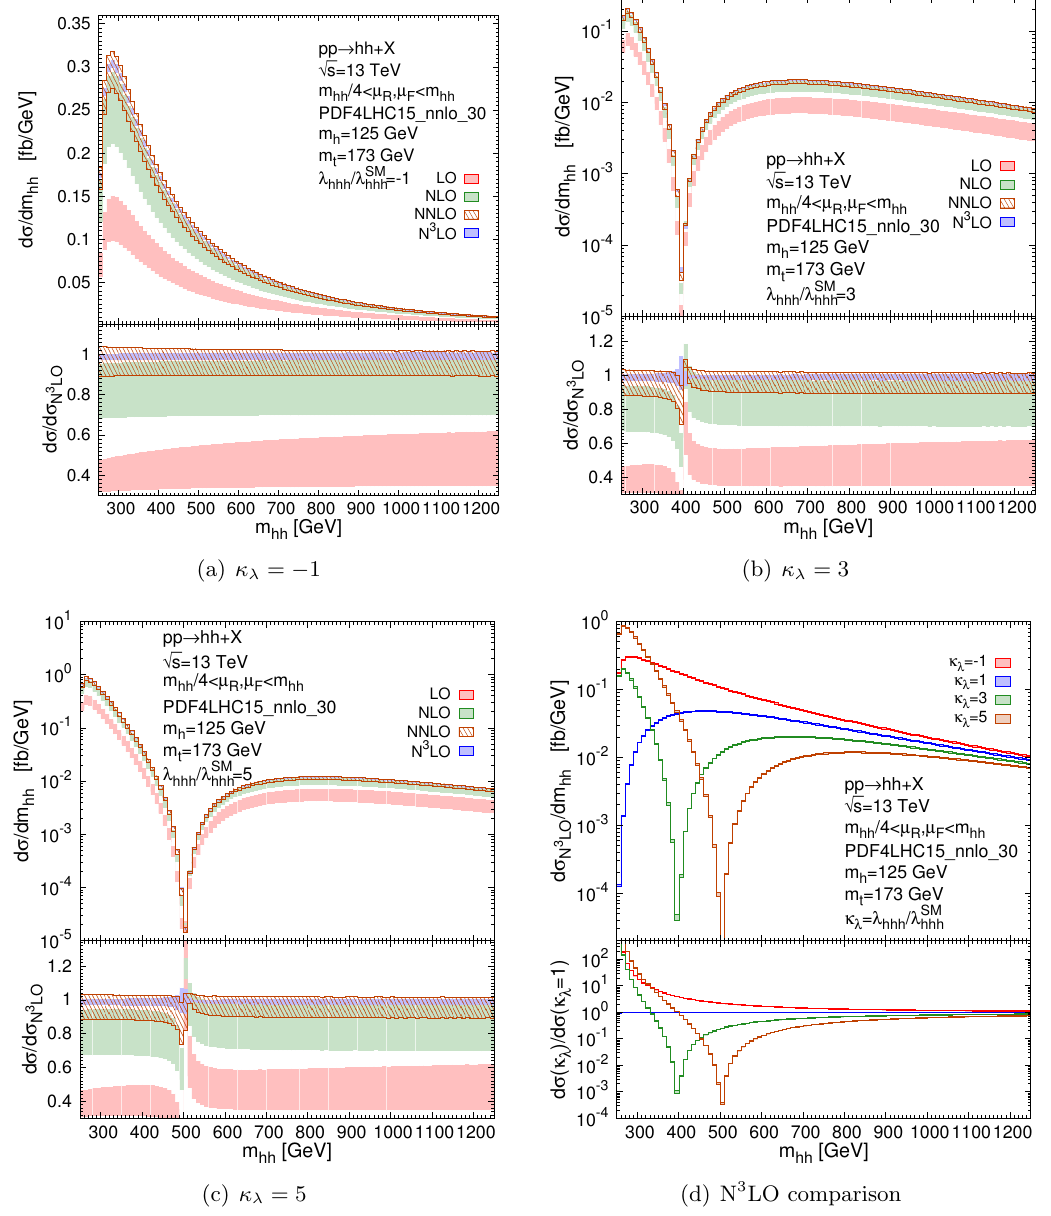
Figure 13 . Invariant mass distributions for the Higgs boson pair production in proton-proton p collisions at s = 13 TeV with di(cid:11)erent (cid:20) (cid:21) = (cid:21) hhh =(cid:21) SM